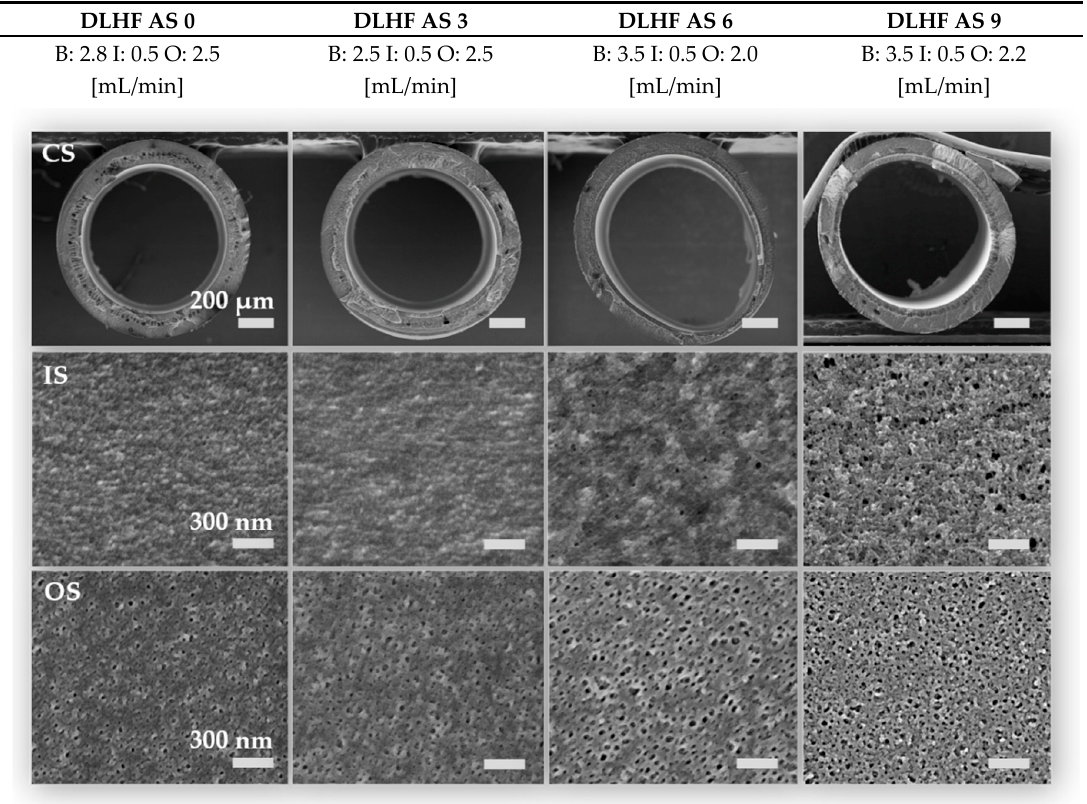
Figure 14. Micrographs of dual layer hollow fiber membrane DLHF AS 0 to AS 9. Flow rates of bore (B) fluid, inner additive solution (I) and outer polymer solution (O) refer to rates in mL/min. CS is the cross sectional view, IS abbreviates inner surface and OS outer surface. Due to agglomerated complexes in solution AS 12, AS 12 is only available as a flat sheet in order to prevent the spinneret from blocking.